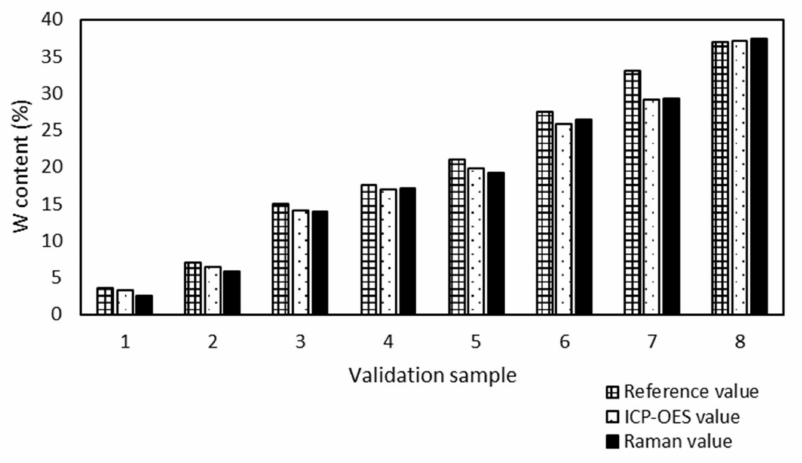
Figure 7. Comparison of ICP-OES and Raman values of W content of validation samples supported SBA-15. The maximum absolute di ff erence is 0.7% (samples 1, 2, and 6) and the minimum is 0.2% (samples 3, 4, and